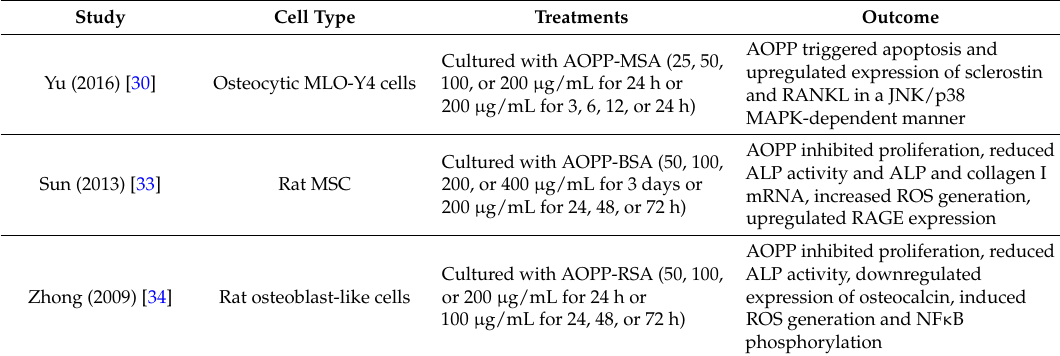
Table 2. In vitro studies of the effect of AOPP on bone